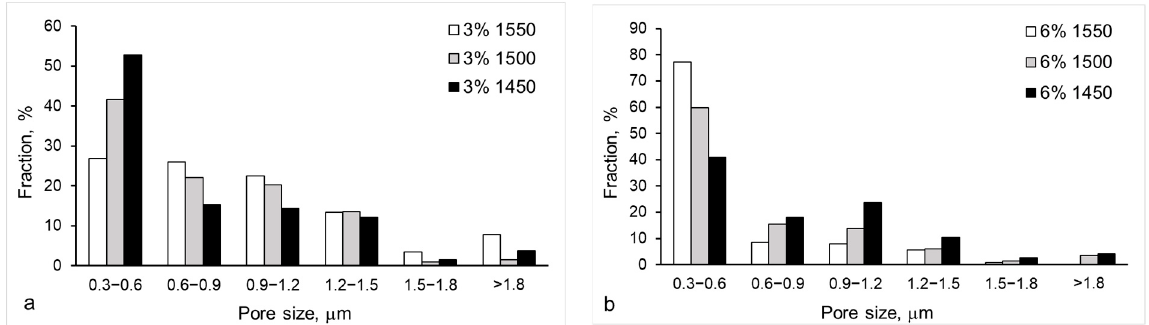
Figure 2. Distributions of pore size for ( a ) 3YSZ and ( b ) 6YSZ ceramics sintered at three tempera- tures.